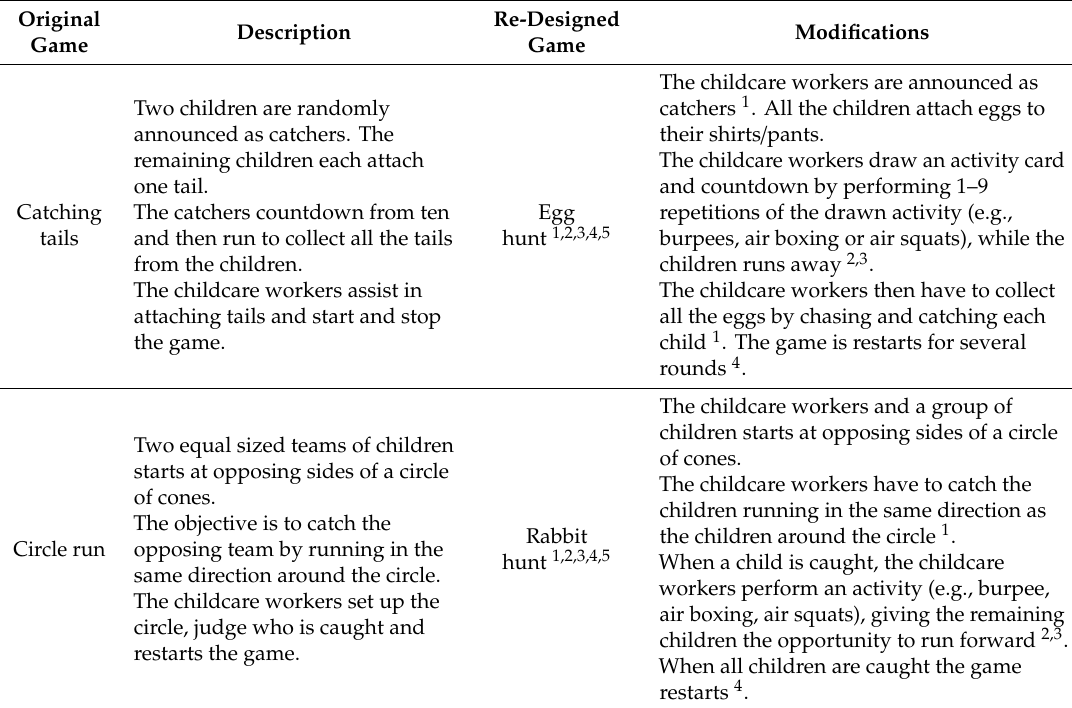
Table A1. Description of games / activities and Goldilocks principle